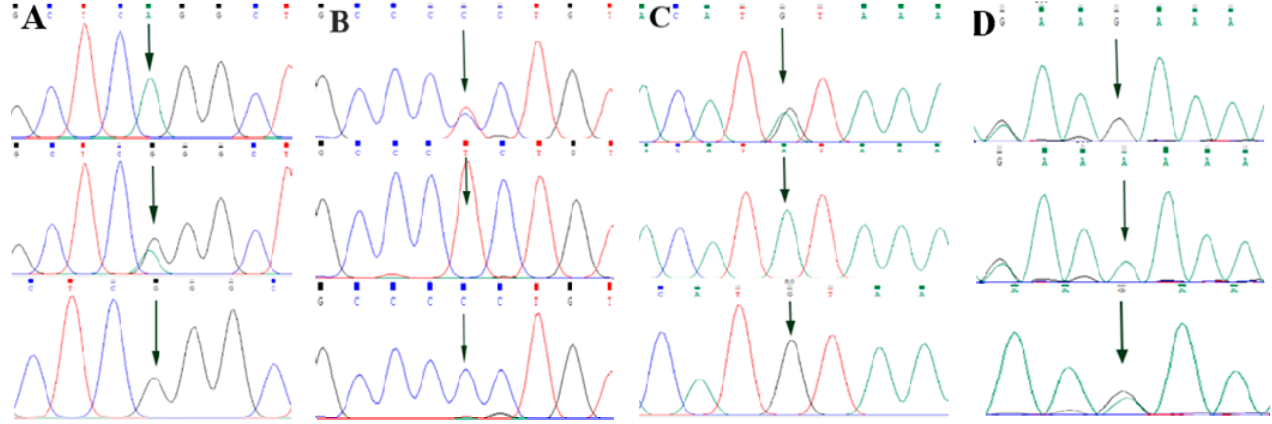
Figure 2. Sequencing peak map of four SNPs in ABCG2 gene sequence. The sequence map at ABCG2 -g.57261A > G site for AG 、 AA and GG ( A ), The sequence map at ABCG2 -g.80952G > T site for GT, GG and TT ( B ), The sequence map at ABCG2 -g.94683A > G site for AG, AA and GG ( C ), The sequence map at ABCG2 -g.120017G > A site for AG, GG and AA ( D ). The arrow indicates the location of the mutation sites.